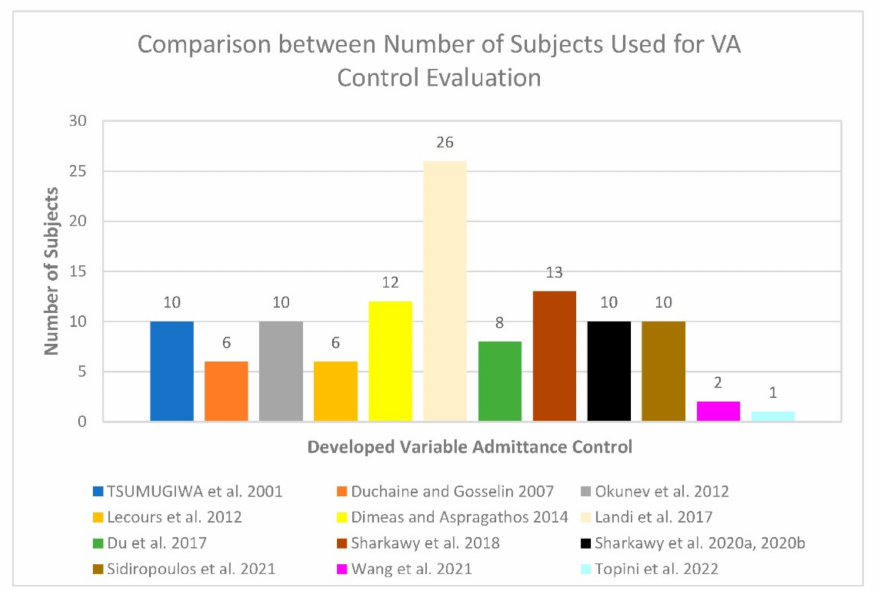
Figure 6. The comparison between the number of subjects used to evaluate the developed VA control, according to the literature presented in this